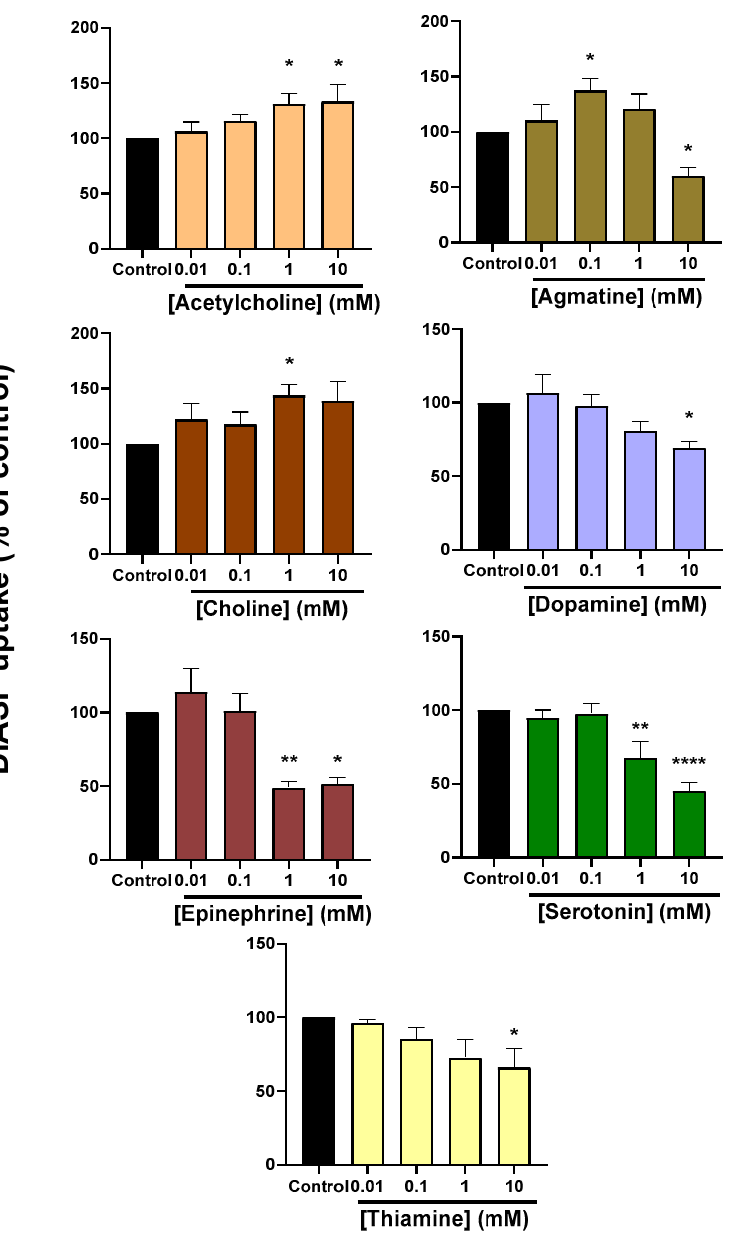
Figure 6. trans -modulation of OCT2 activity by endogenous OCT2 substrates. HEK-OCT2 cells were first incubated in the absence (control) or presence of various concentrations of endogenous OCT2 substrates for 30 min at 37 ◦ C. After washing, cells were next incubated with 10 µ M DiASP, used here as a tracer substrate for OCT2, for 5 min at 37 ◦ C. Accumulation of DiASP was finally determined by spectrofluorimetry and normalised to protein content. Data are expressed as % of DiASP accumulation found in untreated control cells, arbitrarily set at 100%; they are the means ± SEM of at least three independent experiments performed in quadruplicate. *, p < 0.05, **, p < 0.01 and ****, p < 0.0001, when compared to control.